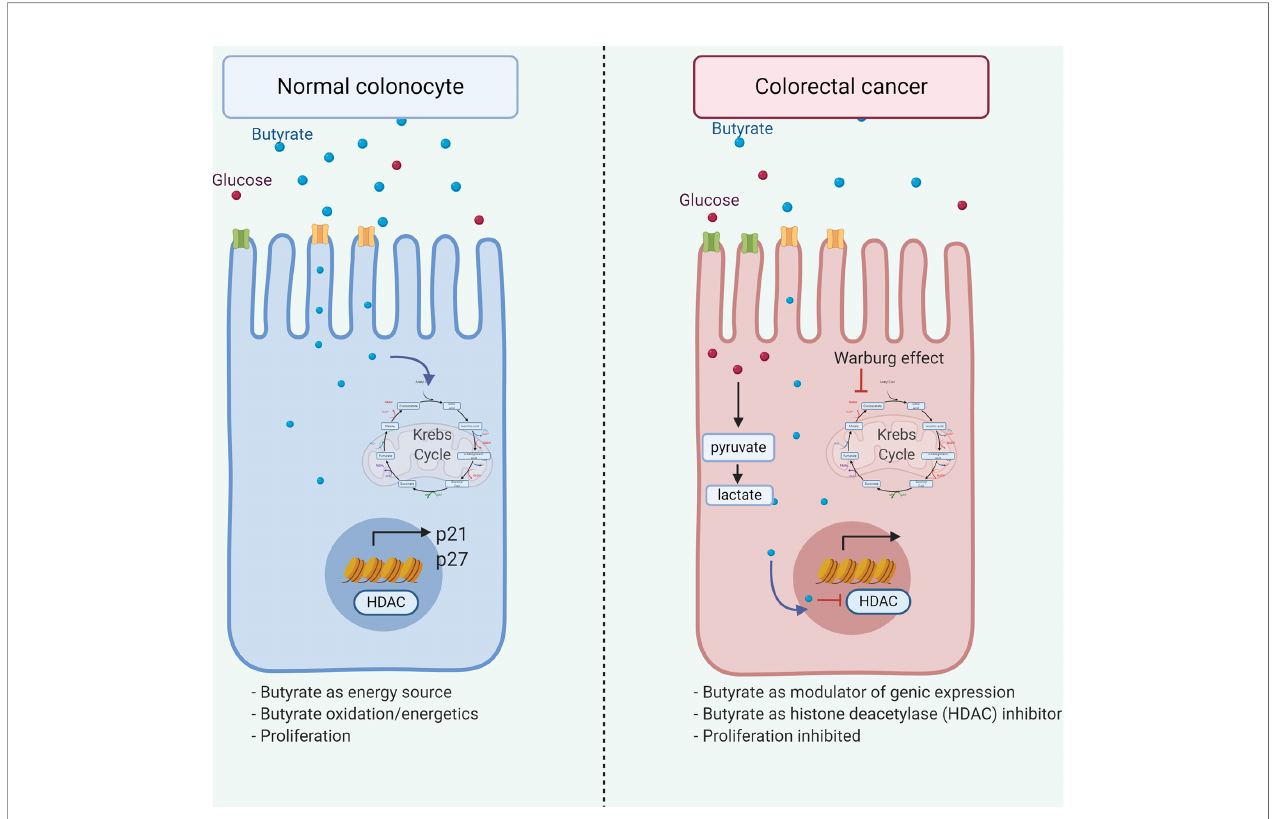
FIGURE 3 | Dual role of butyrate in colorectal cancer. Butyrate exerts dual effects on normal and tumor colonocytes. In normal colonocytes, it functions as an energy source, being metabolized to acetyl-CoA in the Krebs cycle, allowing cell proliferation. Alternatively, in tumor colonocytes due to the Warburg effect, anaerobic glycolysis is the main energetic source, therefore, butyrate does not enter the Krebs cycle and available to the nucleus, modulating gene expression through the HDAC inhibition, leading to p21 and p27 downregulation and inhibiting cell proliferation, thus explaining the bene fi cial effect associated in